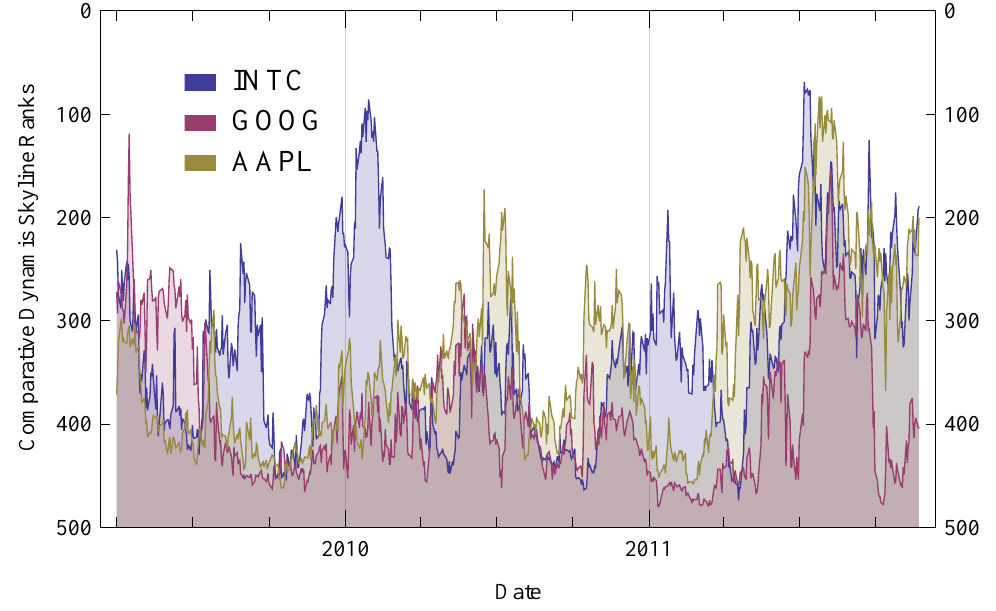
Figure 13. Dynamis skyline rank of our three stocks over the time period